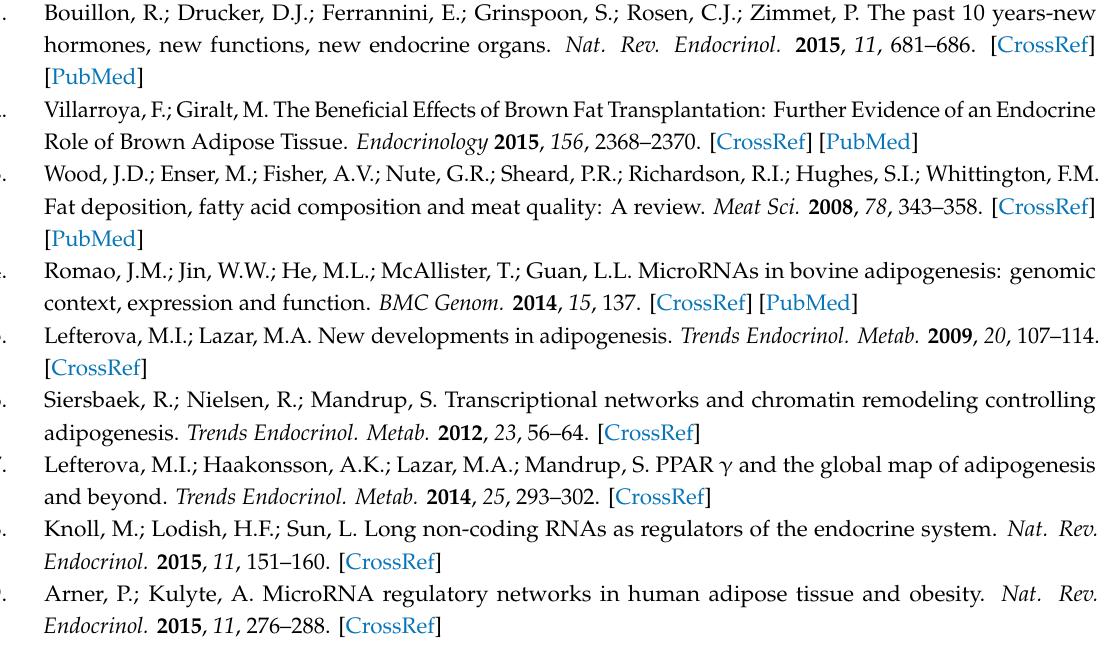
Figure S1: Nucleotide sequence of lncRNA MIR221HG, Table S1: Specific sequence used for semi-quantitative PCR and